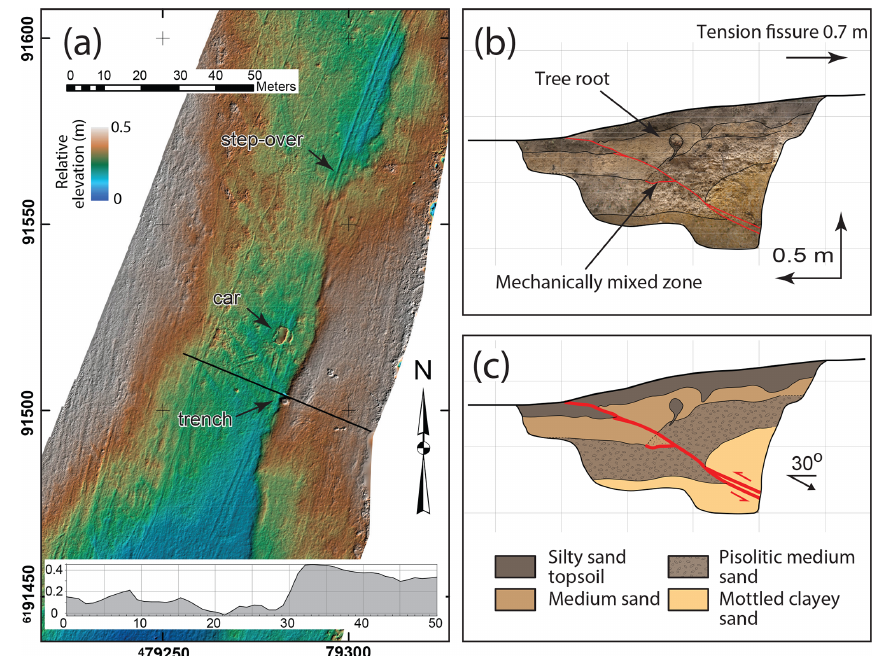
Figure 5. Hand trench location (479285mE, 6191496mN; GDA94/MGA50). (a) Subset of the photogrammetrically-derived UAV DTM (see Fig. 3 for full footprint), with topographic section indicated by the black line. Colour drape has been tilted to remove regional topographic slope and enhance relative differences. (b) Photomosaic of the north wall of the hand trench showing folded and displaced strata and (c) interpretation of stratigraphy and structure of the north wall of the hand